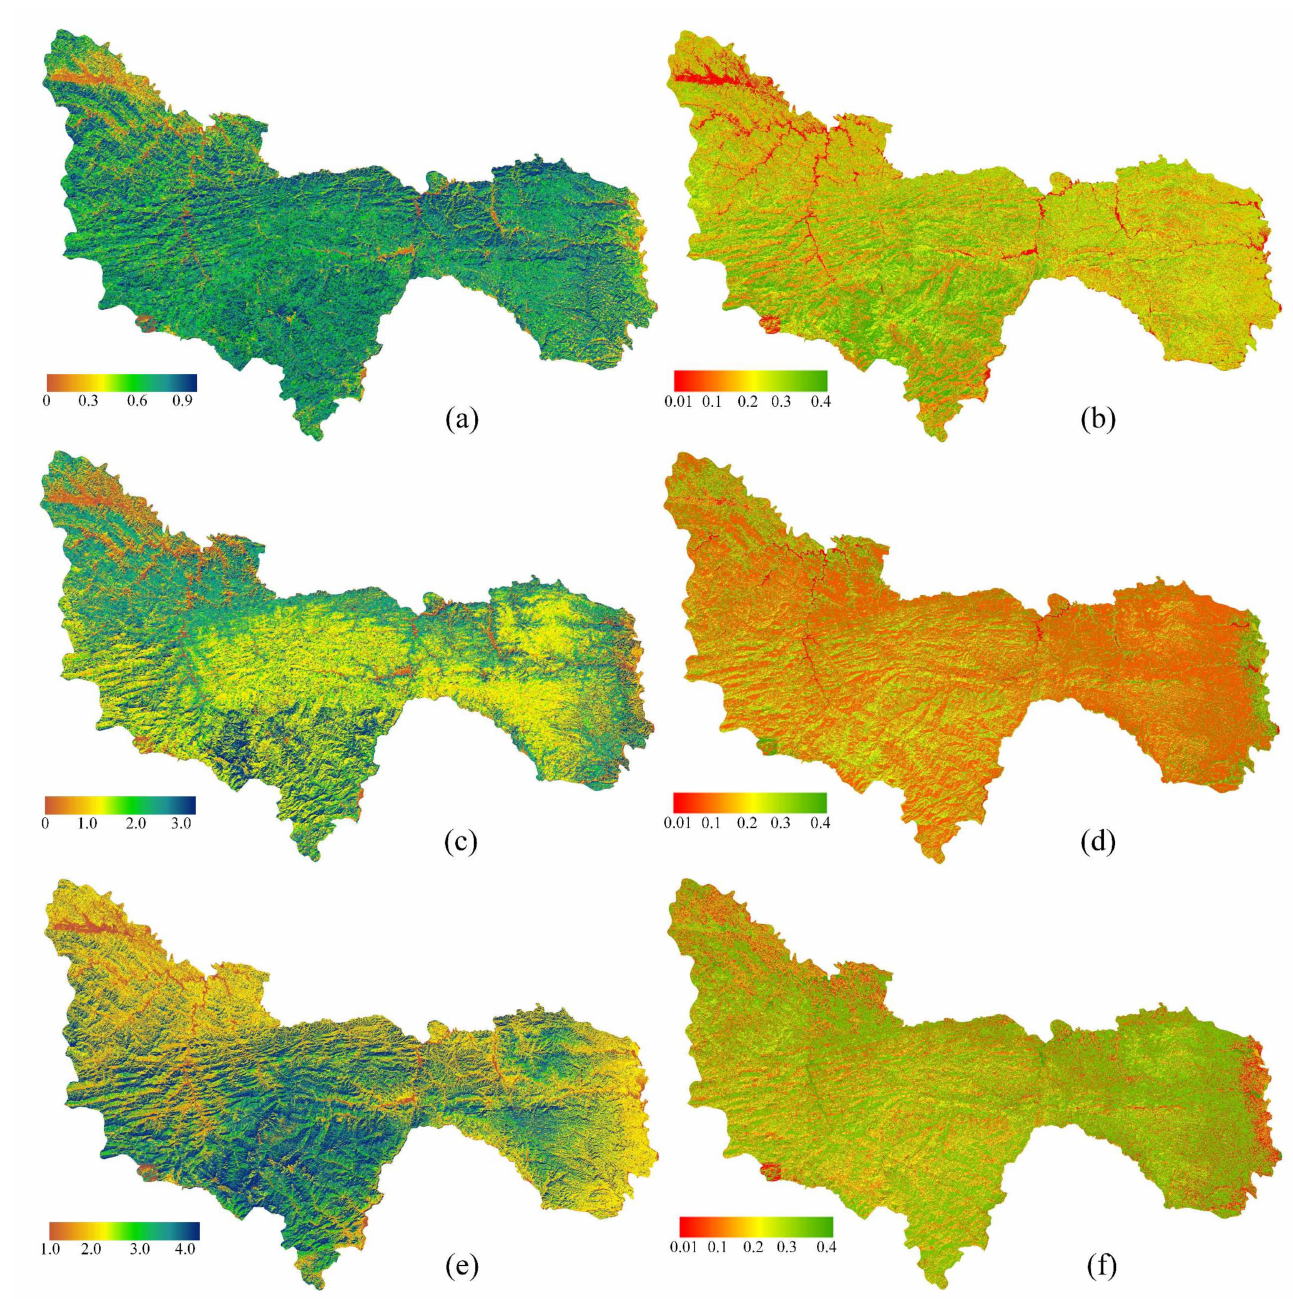
Figure 8. Prediction of the ( a ) Simpson, ( c ) Shannon-Wiener, and ( e ) texture diversity indices for pixels corresponding to the study area. ( b , d , f ) correspond to the confidence intervals associated with the three respective predictions of diversity indices based on spatial cross-validation at pixel